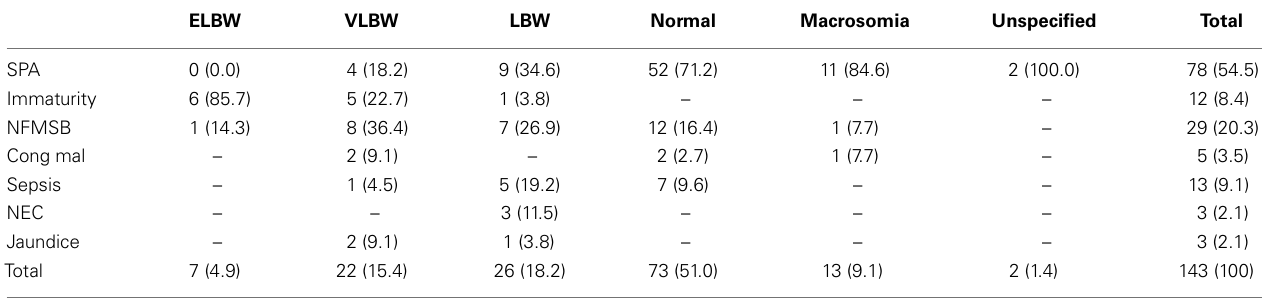
Table 9 |Wigglesworth classification of perinatal mortality